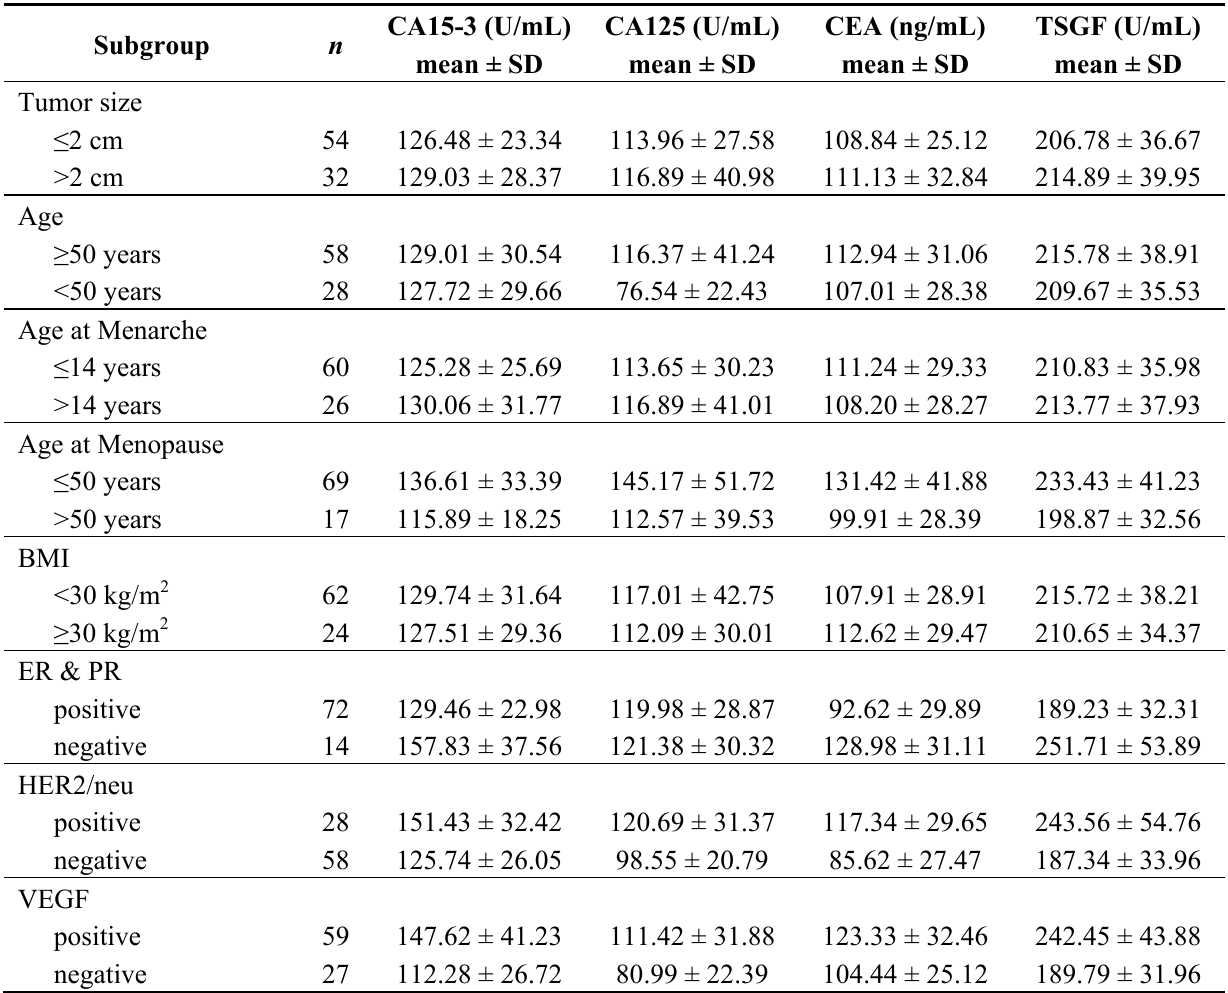
Table 4. The impact of various parameters on nipple discharge biomarker levels in the breast cancer group ( n =